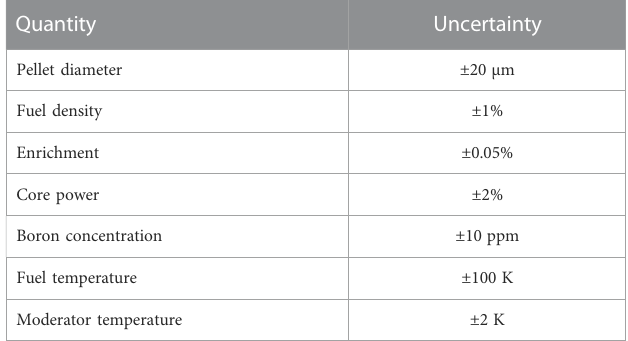
TABLE 5 Technological uncertainties provided in SFCOMPO